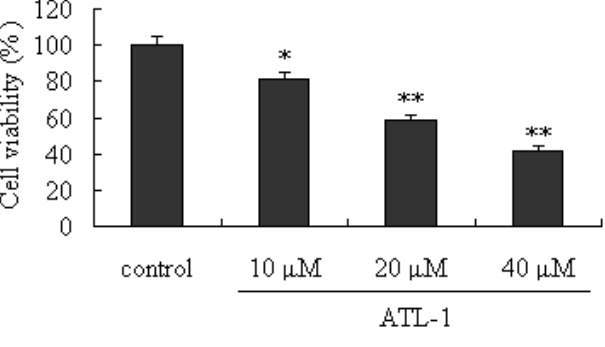
Figure 6. Cytotoxic effects of ATL-I on HCC827 cells. Cells were treated with ATL-1 at the concentrations of 10, 20, and 40 μ M for 48 hours, the cells viabilities were determined by the MTT assay, * p < 0.05, ** p < 0.01, vs. control.